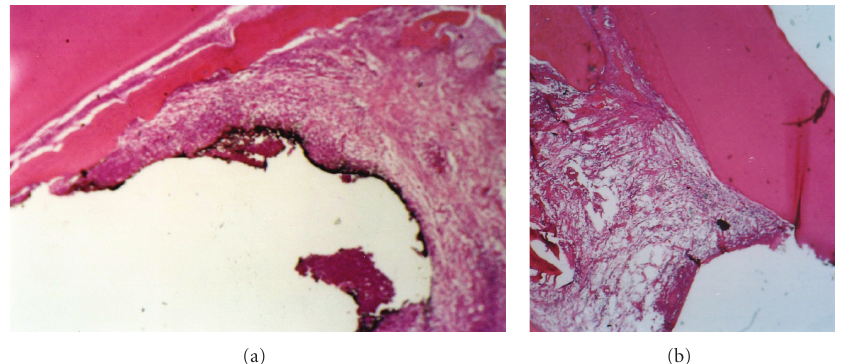
Figure 4: Periodontal tissue response in the dog following an application of bFGF for 8 weeks. Absence of inflammatory infiltration and formation of connective tissue can be seen (magnification ×